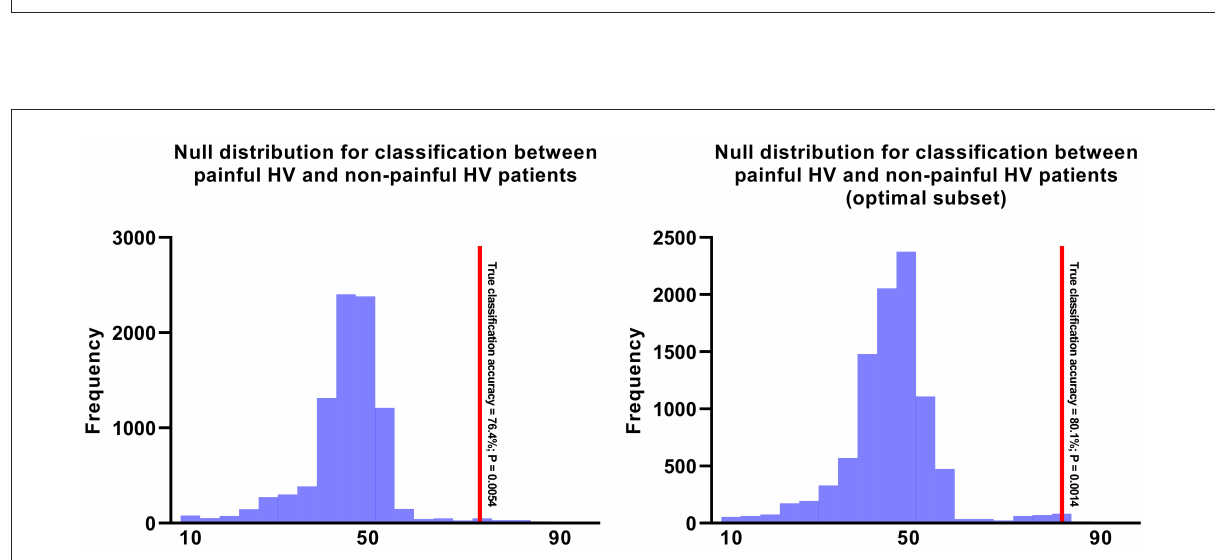
FIGURE3 The null distributions for Painful HV vs. Pain-free HV. The left panel illustrates the null distribution of 10,000 permutations for Painful HV vs. Pain-free HV using the entire feature set. The right panel illustrates the null distribution of 10,000 permutations for Painful HV vs. Pain-free HV using the optimal feature set including hallux valgus angle, inter-phalangeal angle, distal metatarsal articular angle, metatarsal adducent angle, metatarsal protrusion